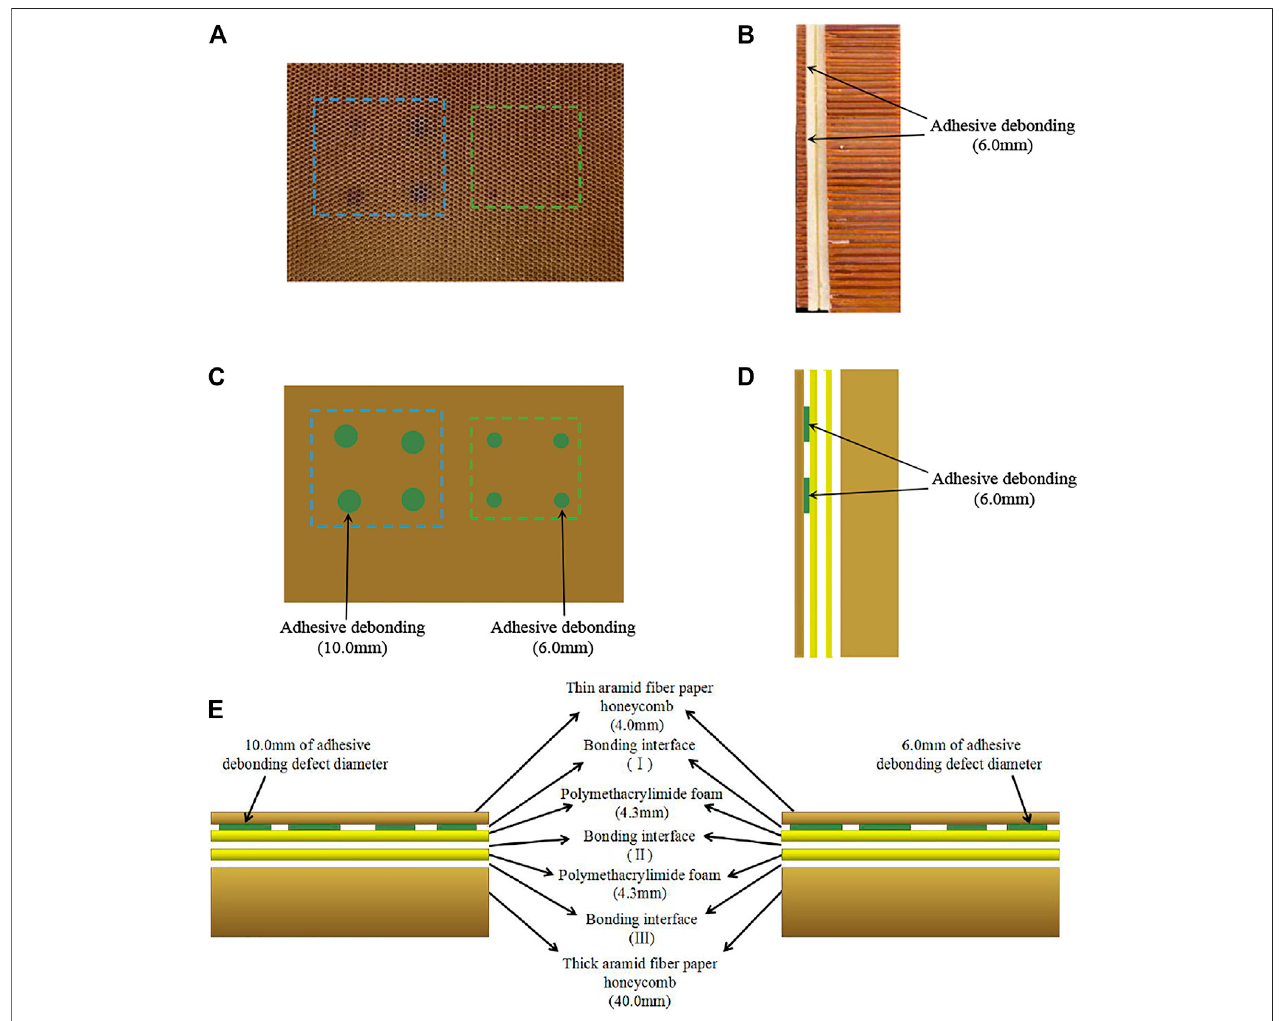
FIGURE 3 | The actual photos, defect location and size, structure diagram of aramid fi ber paper honeycomb and polymethacrylimide foam sandwich composite material. (A) the actual photo (top view) , (B) the actual photo (side view), (C) the diagram of defect location and size (top view) , (D) the diagram of defect location and size (side view), (E) the structure